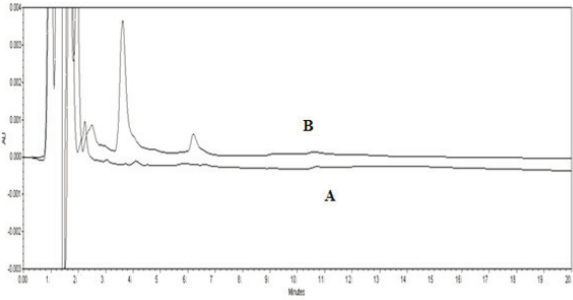
Figure 2: HPLC chromatogram of the analysis of lixivaptan in drug-free plasma: (A) blank plasma, (B) mouse plasma spiked with 200 ng mL -1 and 2 μg mL -1 of lixivaptan and DC, respectively.